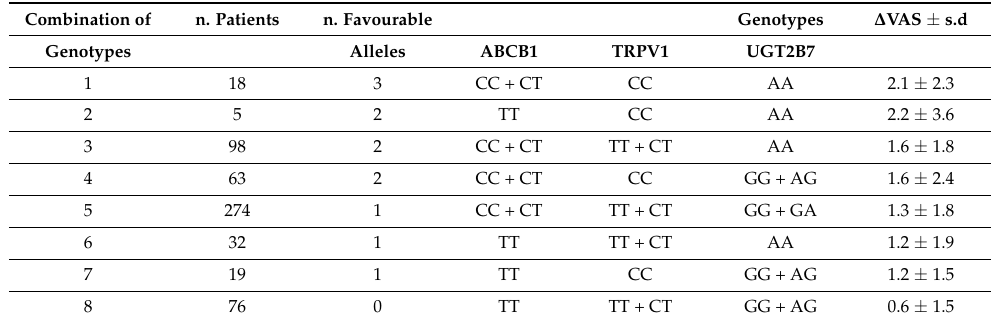
Table 2. Genotypes groupings based on allelic combinations and ordered by the number of favourable combinations for pain